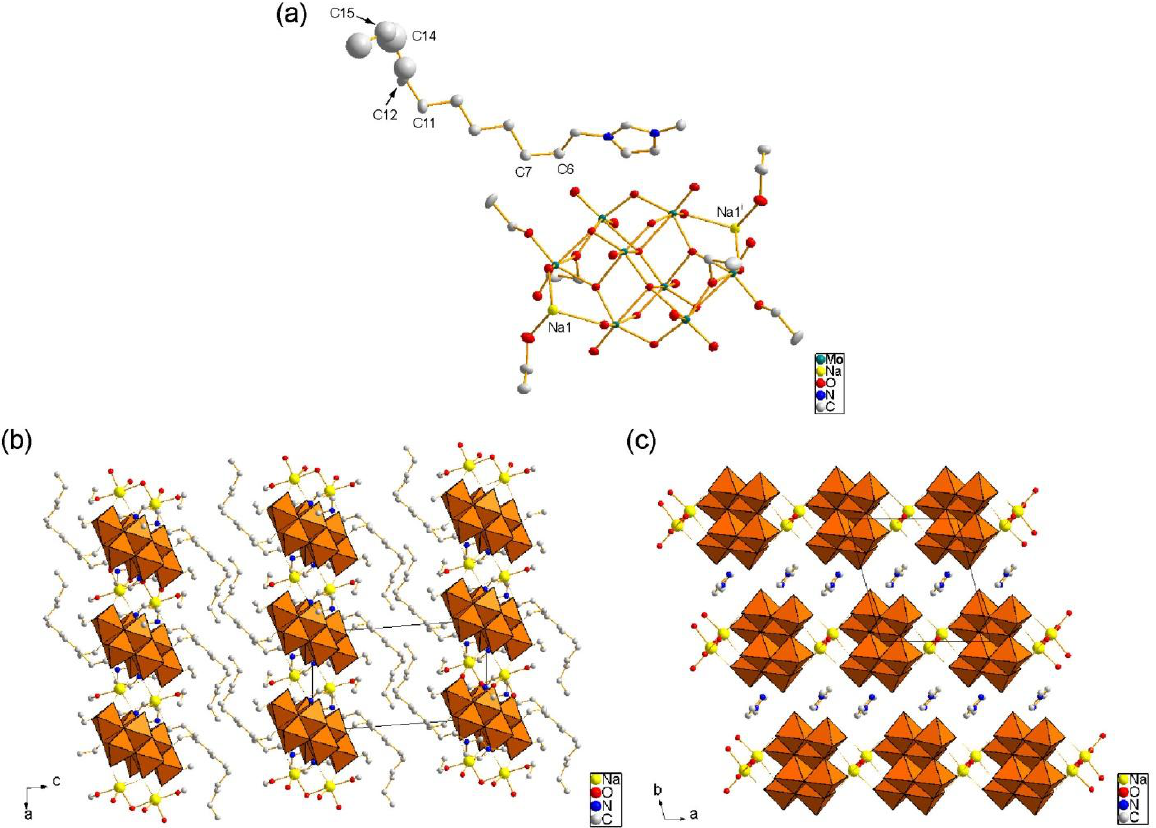
im-Na-Mo . H atoms are omitted for 12 8